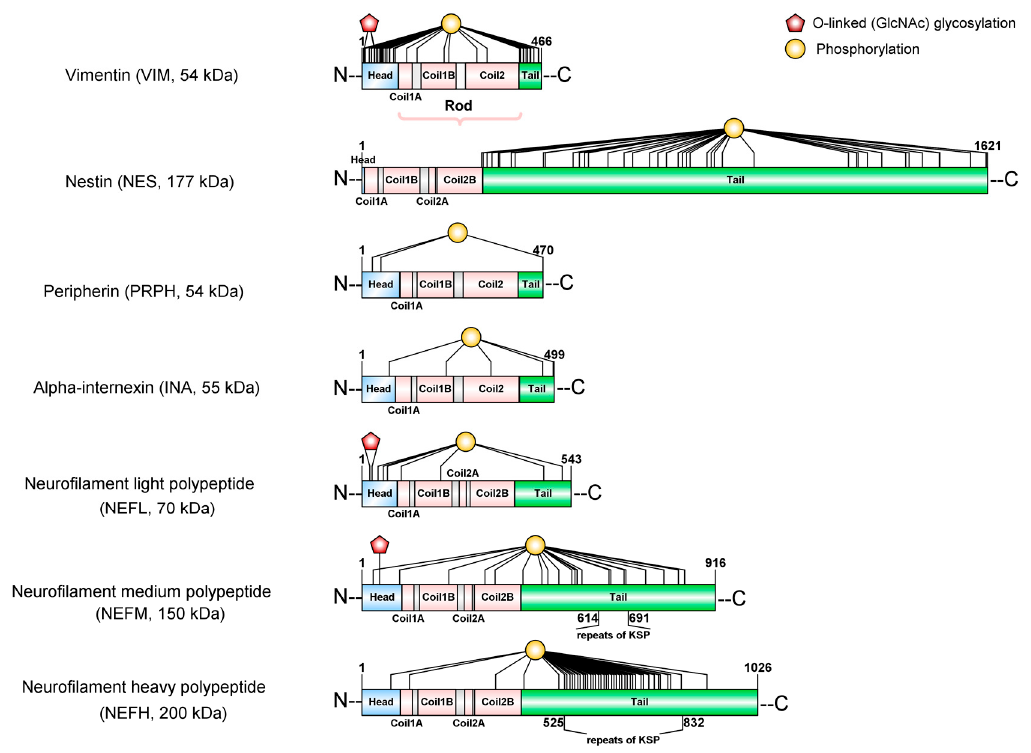
Figure 2. Schematic representation of the domains and posttranslational modifications of intermediate filaments. Vimentin and nestin are the subunits of neurofilaments (NFs) in the developing nervous system. Neurofilament light (NF-L), neurofilament middle (NF-M), neurofilament heavy (NF-H), α -internexin, and peripherin are subunits of NFs in the mature nervous system. All subunits share a conserved molecular structure composed by (i) an alpha-helical coiled-coil rod domain; (ii) a variable globular head at the N-terminal; (iii) and C-terminal tail domains. The chemical properties neurofilament subunits are modulated mostly by two posttranslational modifications: phosphorylation and O-GlcNAcylation. The tail domains of NF-M and NF-H are subject to extensive phosphorylation on Lysine-Serine-Proline repeats (KSP). NF proteins (NF-L, NF-M, NF-H) and vimentin are glycosylated by O-linked β - N -acetylglucosamine (O-GlcNAc) at the hydroxyl groups of serine (Ser) or threonine (Thr) residues of their head domains. Phosphorylation and O-GlcNAcylation residues are shown.